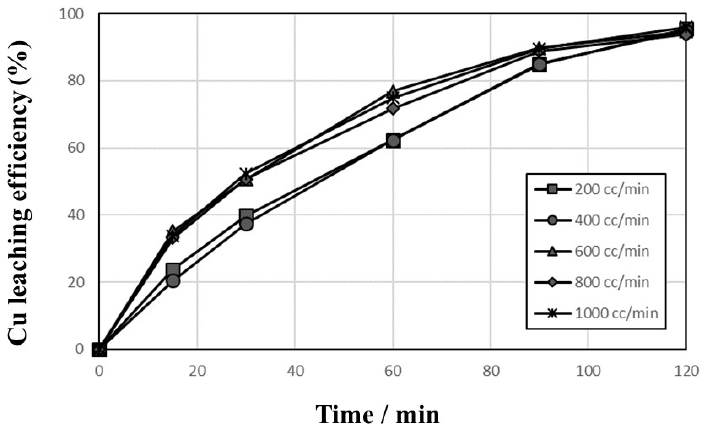
Figure 5. Effects of O 2 gas flow rate on the leaching behaviors of Cu in 1 mol/L sulfuric acid solu- tion at 90 °C and 600 rpm with 10,000 mg/L Cu 2+ , 1% pulp density, and 200 cc/min–1000 cc/min O 2